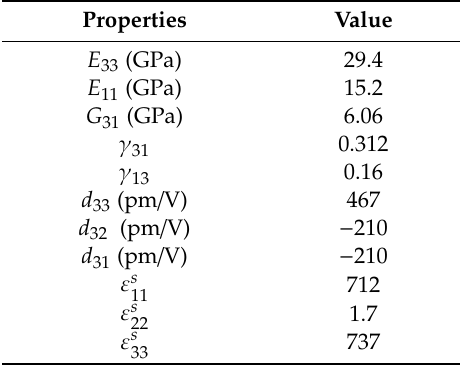
Figure 7. The homogenized PFP bending test’s configuration. Two PFPs (85 × 57 mm 2 in size) were attached to the front and the back of an aluminum beam. The PFP1 was driven by a voltage to be